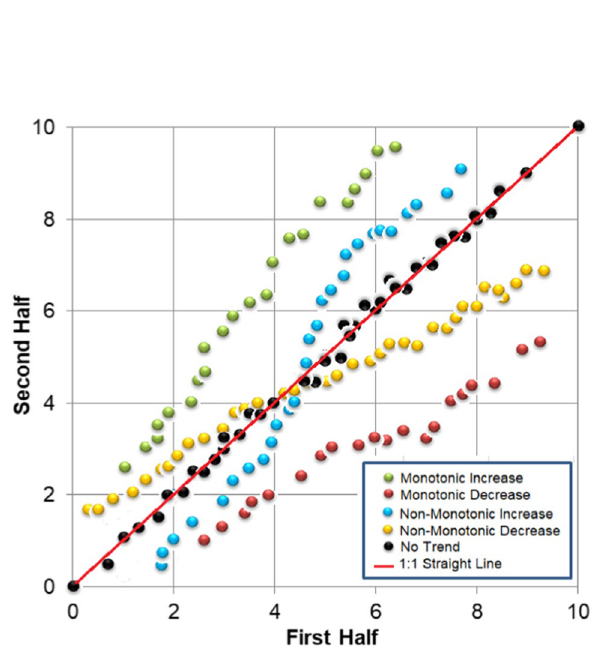
Fig. 4 Distinctions between Şen-ITA (ordered data) and NO-ITA (non-ordered data)